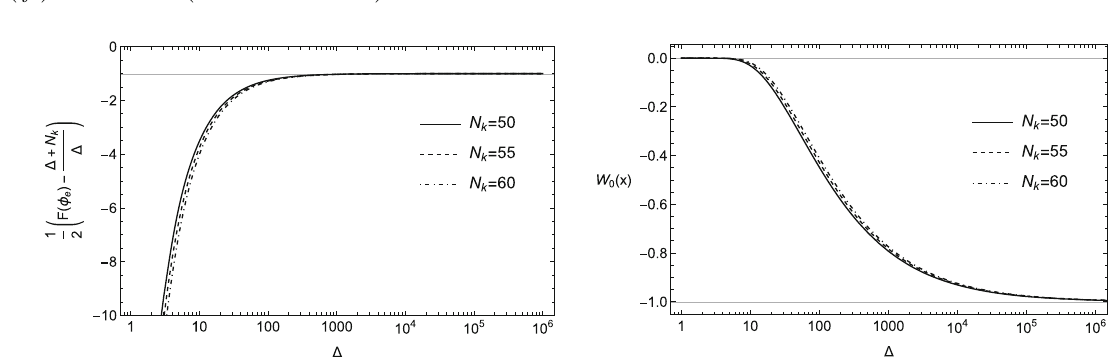
The shaded dark- and light-blue regions represent the 1 σ and 2 σ confidence contours of the Planck+BICEP/Keck 2018 data [28], respectively. The diagonal gray lines indi- cate the different values of Δ ; for example, Δ = 20 for the orange line. The purple lines represent the number N k of e -